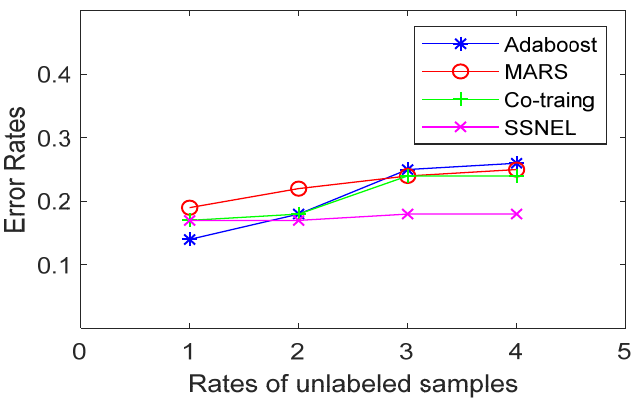
Figure 6. Error rates of the compared methods (yeast).